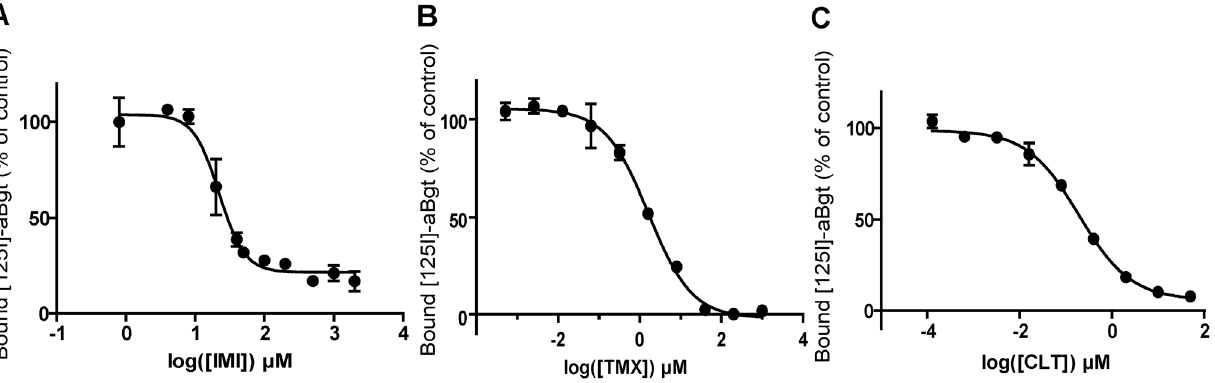
Figure 3. Neonicotinoids inhibition of [ 125 I]- a -Bungarotoxin specific binding. Inhibition curves were determined on membranes of whole parthenogenetic adults of pea aphid Acyrthosiphon pisum for three neonicotinoids: A) imidacloprid (IMI), B) thiamethoxam (TMX) and C) clothianidin (CLT). Results are means of four experiments. Error bars represent the SEM. doi:10.1371/journal.pone.0096669.g003 different toxicities against A. pisum . All results are presented in table 4 as means of 6 to 8 experiments. We found that TMX was the most toxic (LC 50 = 0.259 m g/ml) and CLT was the least toxic (LC 50 = 3.458 m g/ml) after 24 h of exposure. The toxicity of IMI was intermediate with an LC 50 of 0.913 m g/ml. The LC 50 values were significantly lower after 48 h of exposure. Interestingly IMI and TMX showed similar effect (LC 50 = 0.038 and 0.034 m g/ml, respectively) whereas CLT remained the least toxic (LC 50 = 0.118 m g/ml). We suggest that the potency of TMX could be associated to its double action: directly and after metabolization to CLT as previously proposed [25]. Indeed HPLC/MS analysis showed that TMX was metabolized to CLT (Figure 5). In TMX- treated aphids (using TMX at LC 50 = 0.034 m g/ml) we obtained